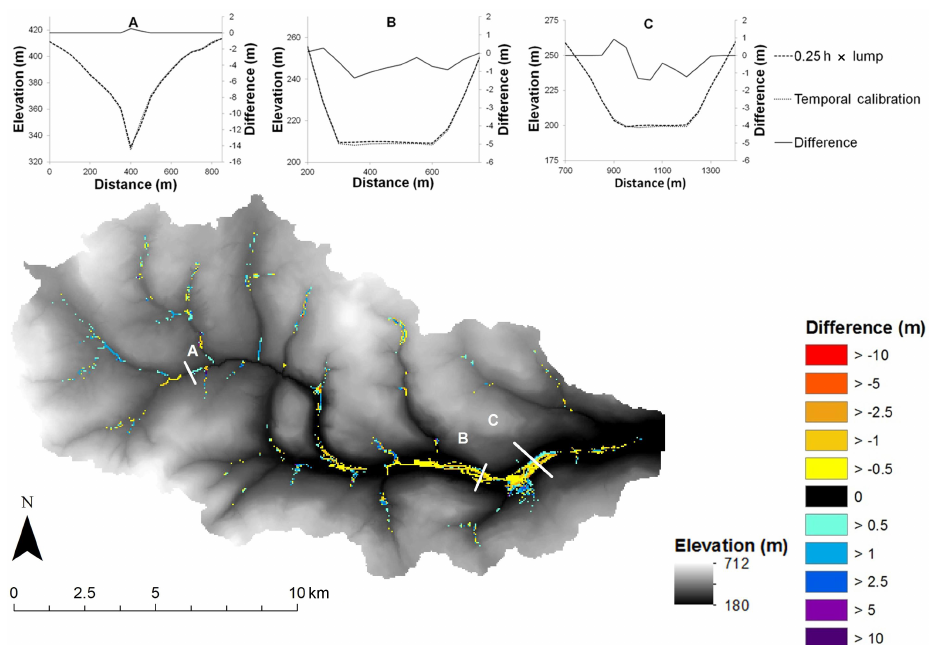
Figure 6. DEM of difference for the adjusted temporal-resolution comparison. The differences shown are elevations from the 24h × Lump (2.0 factor) simulation minus the elevations from the 0.25h × Lump. Yellows to reds indicate where the first (24h × Lump 2.0) simulation has eroded more and deposited less than the second (0.25h × Lump) simulation. Blues indicate more deposition and less erosion.